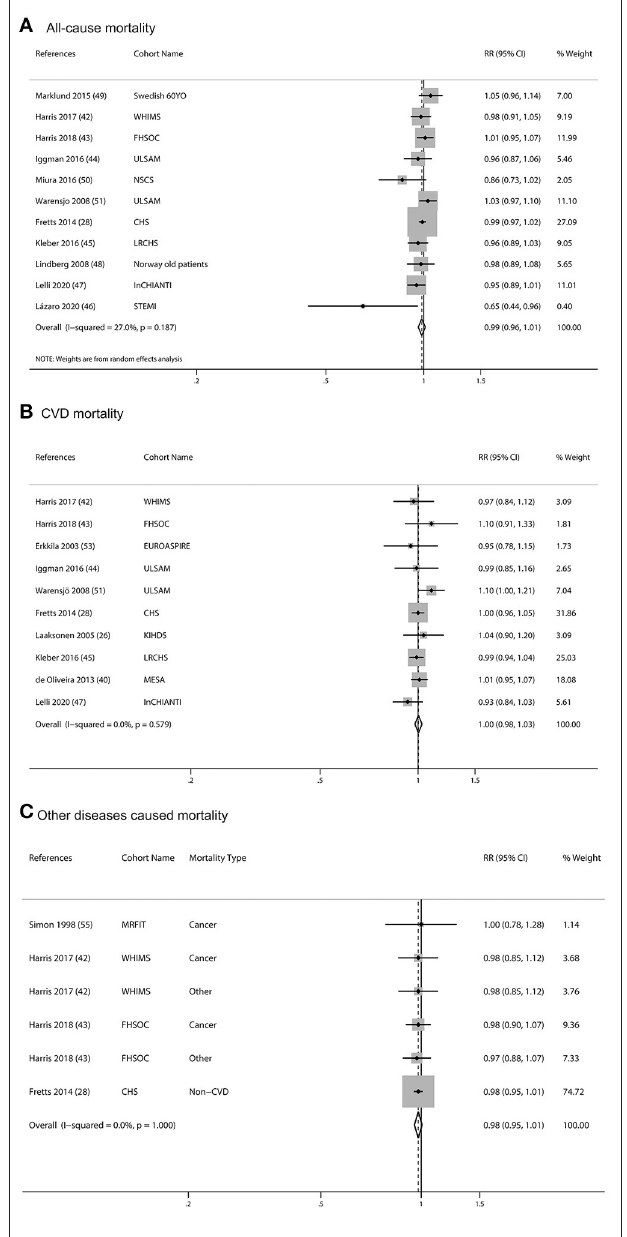
FIGURE 4 | Meta-analysis of the associations between per SD increment biomarkers of ALA in body tissue and mortality from all-cause (A) , CVD (B) , and other diseases (C) in prospective cohort studies. CI, confidence interval. The horizontal lines denote the 95% CIs, some of which extend beyond the limits of the scales. The square is proportional to the weight of each study. The diamond represents the overall pooled estimate of the relative